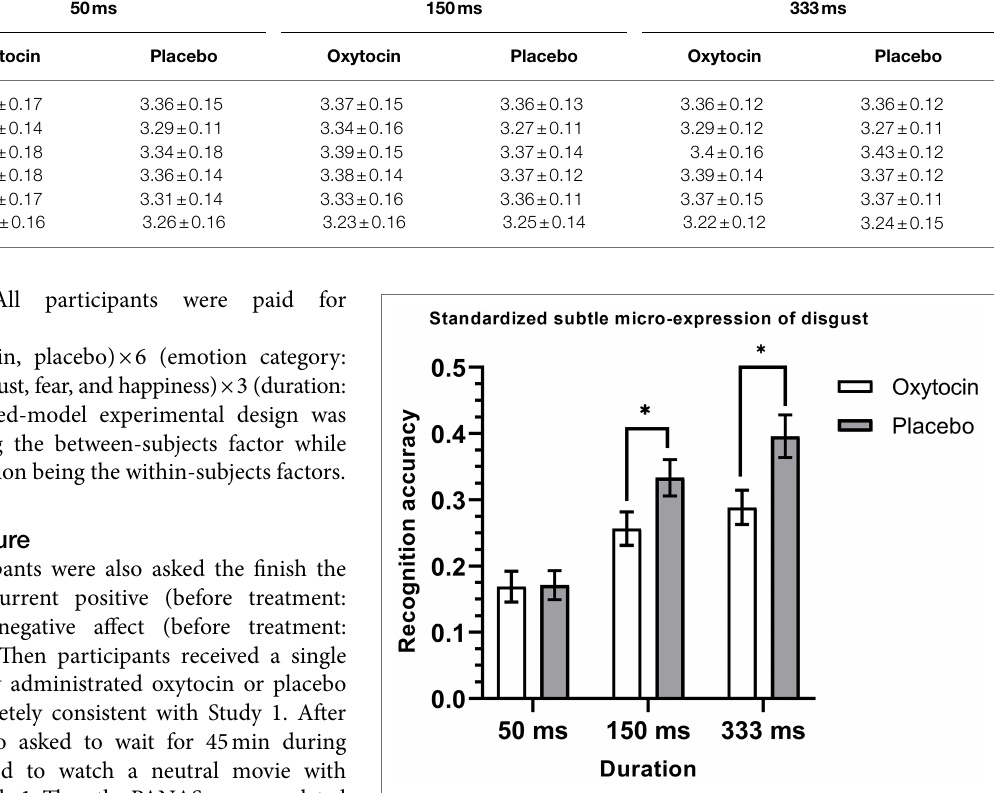
FIGURE 2 | Mean recognition accuracies of standardized subtle micro- expressions of disgust. Error bars represent standard errors. The symbol * indicates that the differences were